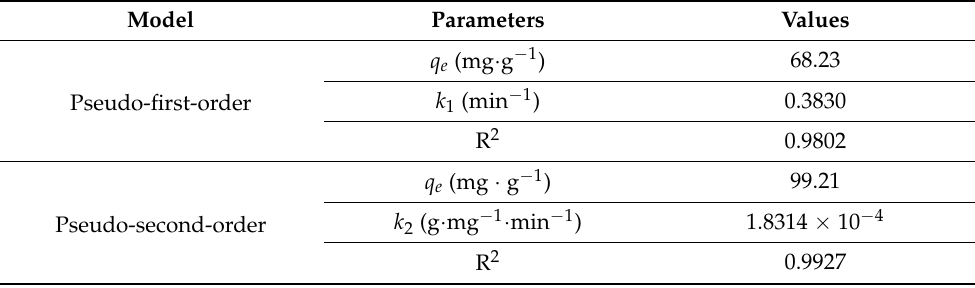
Figure 8. Effect of initial concentration of Cr(VI) aqueous solution on the adsorption capacity of PVDF–2GO@GO nanofibrous membranes.